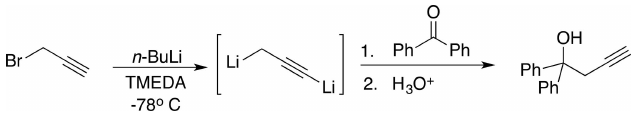
Figure 3 A synthetic scheme for the preparation of the title compound.